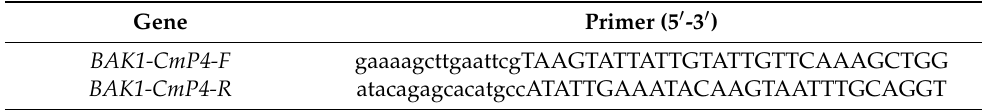
Table 4. Primer sets used in bait promoter cloning.